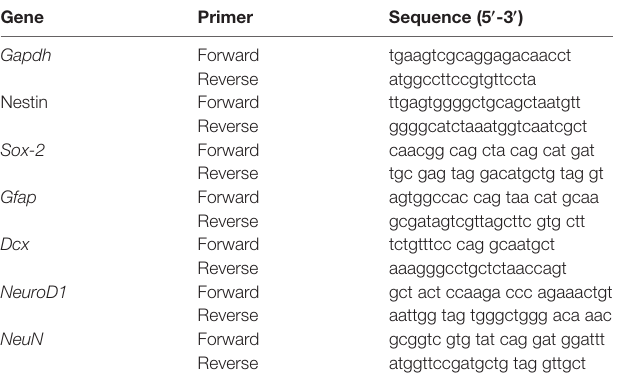
TABLE 1 | The primer sequences used for real-time PCR studies. Gene Primer Sequence (5 (cid:48) -3 (cid:48) )